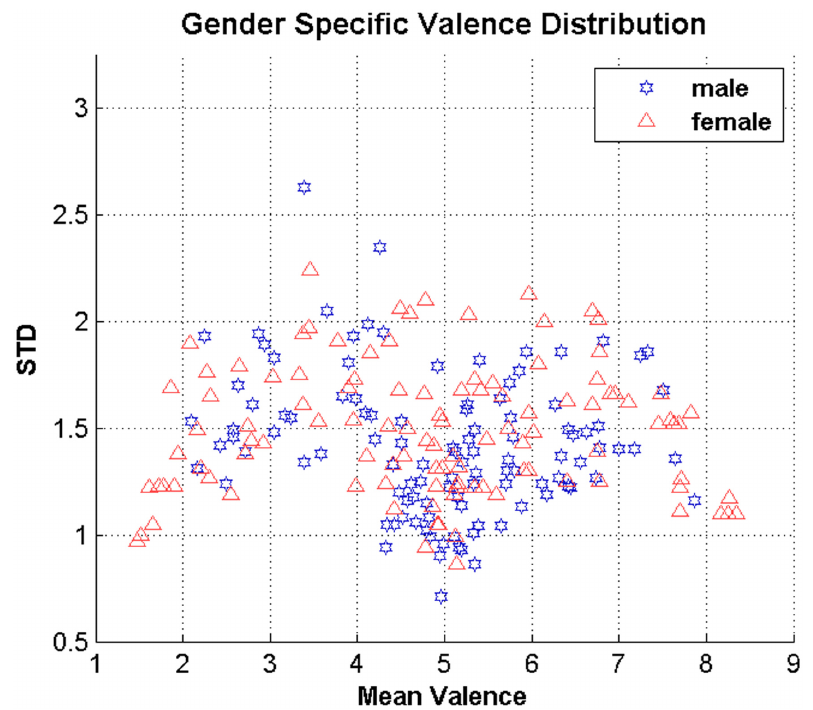
Fig 1. Analysis of gender and emotional distribution of images. As visualized, there is a difference between the ratings of female and male observers. Each image is visualized in terms of its mean valence and standard deviation ratings in regard to the